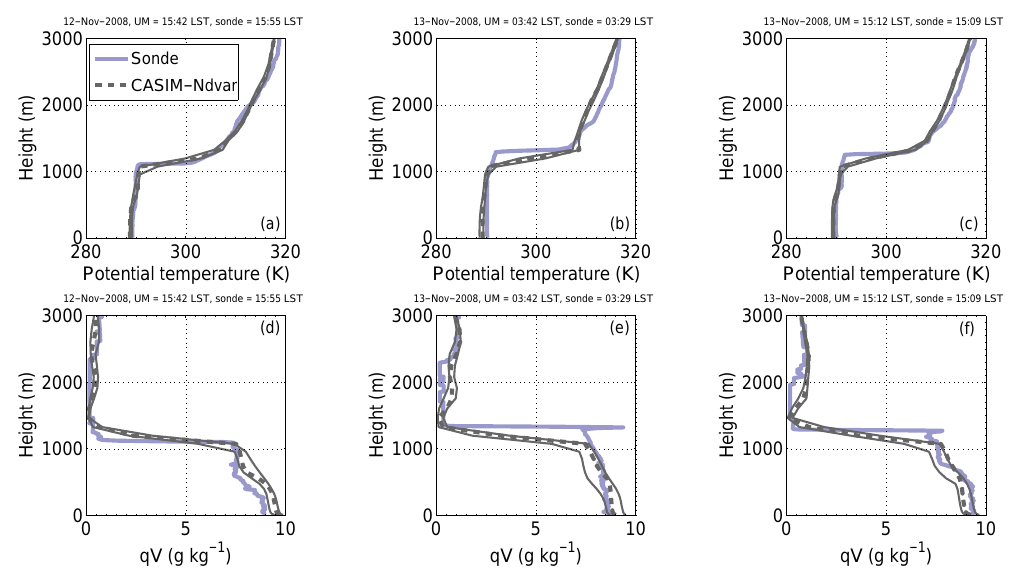
Figure 13. Profiles of potential temperature (top row) and water vapour mixing ratio (bottom row) from radiosondes released from the RV Ronald H. Brown (labelled “sonde”) and from the control UM run (CASIM-Ndvar). Three different radiosonde times are shown; 15:55LST on 12 November (left), 03:29LST on 13 November (middle), and 15:09LST on 13 November (right), with the closest avail- able UM time being used (see titles of each sub-plot). The closest profile in the UM to the ship location is shown as the dashed grey line and the surrounding thin grey lines show the 10th and 90th percentiles at each height from all of the profiles in a 1 ◦ × 1 ◦ region around the